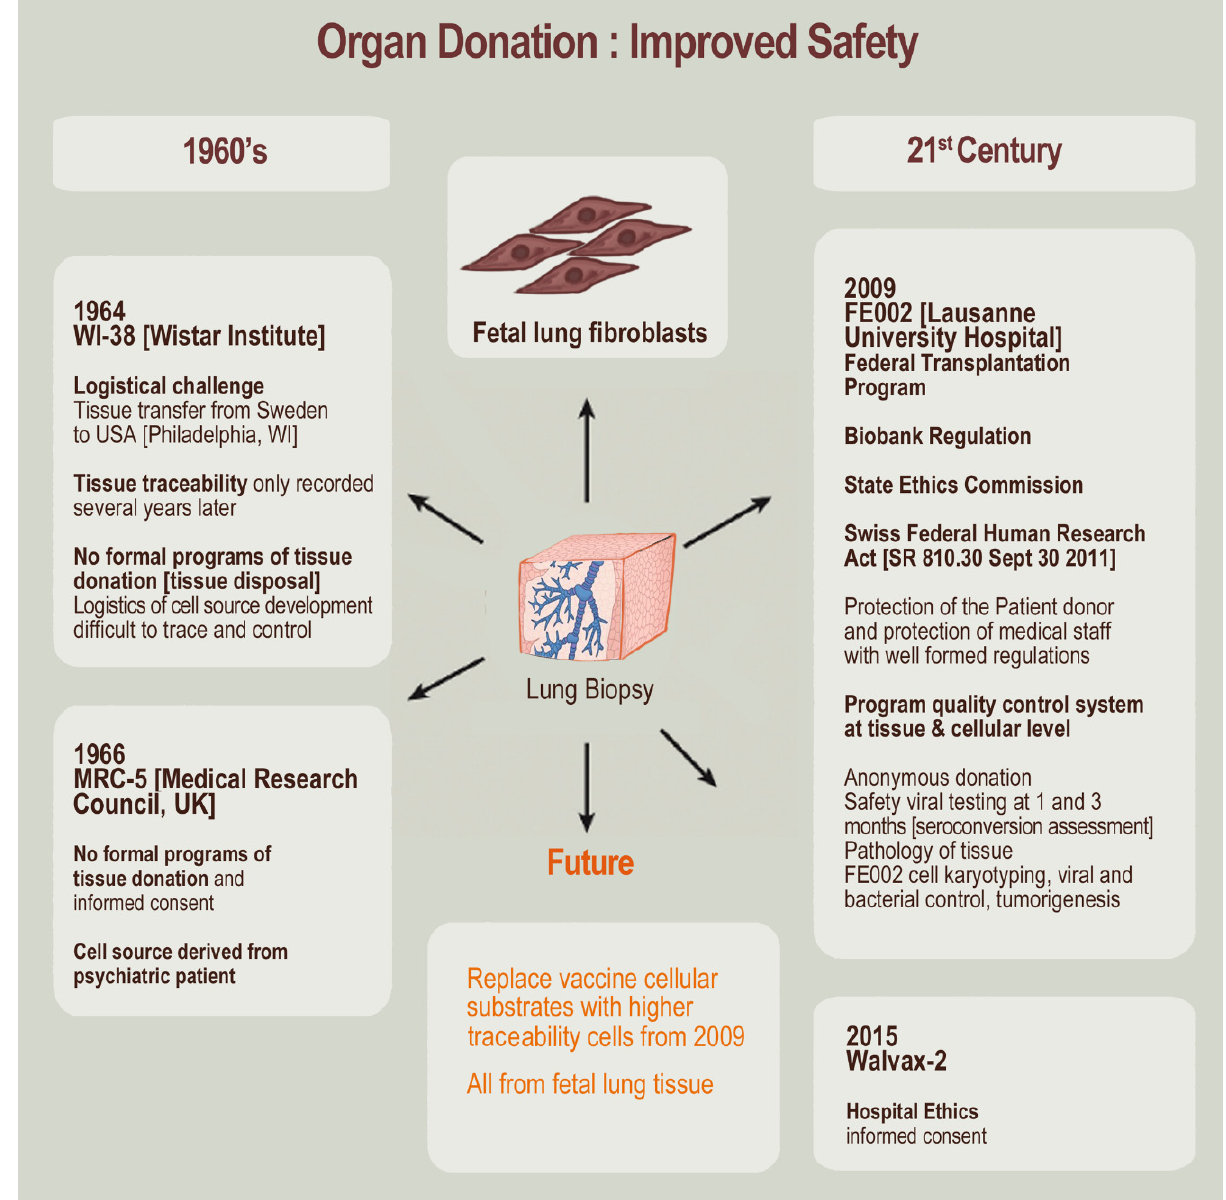
Figure 6. Improved safety of organ donations for diploid cell source establishment with the evolution of practices between the 1960s and the 21st century. Prenatal lung tissue-derived diploid cell sources have been employed as major substrates for vaccine production since the 1960s. The first source was developed in 1964 (i.e., WI-38 cell type), and a later source was developed with better tracing and processing of tissue in 1966 (i.e., MRC-5 cell type). Based on historical practices, comparable modern cell sources were developed between 2009 and 2015 (e.g., FE002-Lu and Walvax-2 human diploid cell types) with enhanced traceability and additional safety features related to ethics and regulatory oversight.